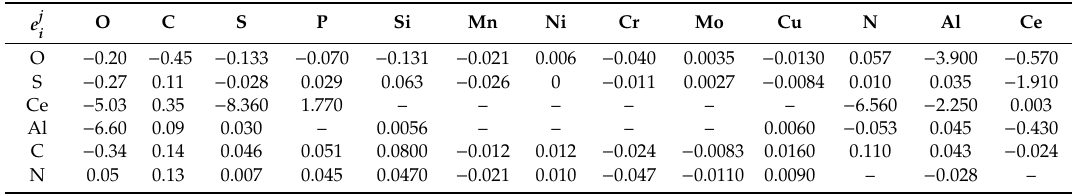
Table 3. Interaction coe ffi cients of elements in molten steel at 1873 K.